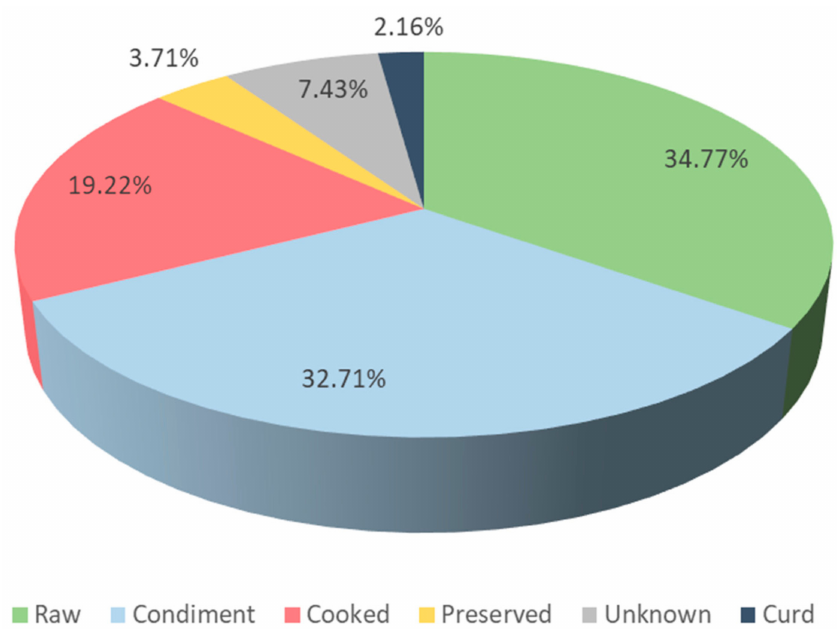
Figure 4. Modes of preparation of wild food plants in the area studied.